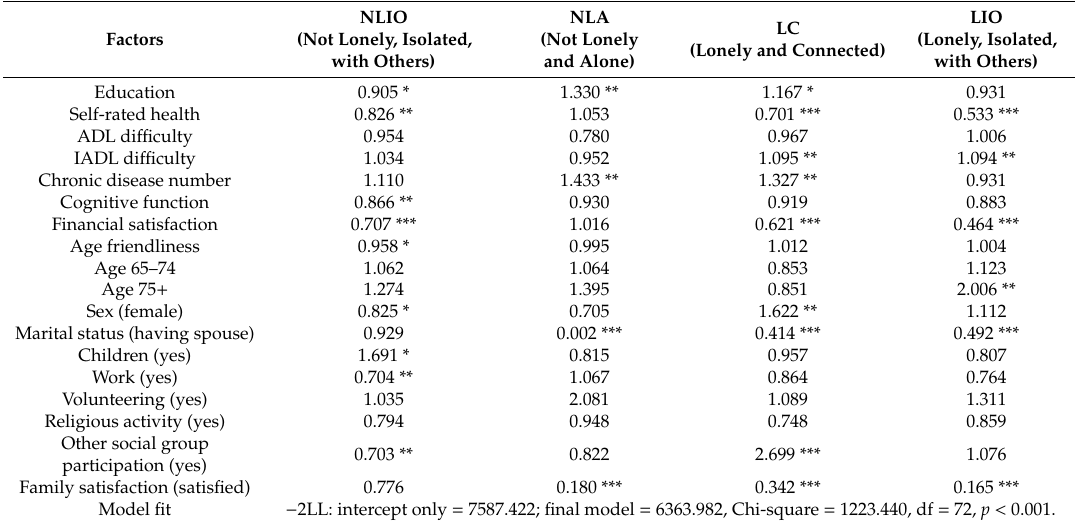
Table 4. Factors related to LIL combinations by multinomial logistic regression (odds ratios). Factors